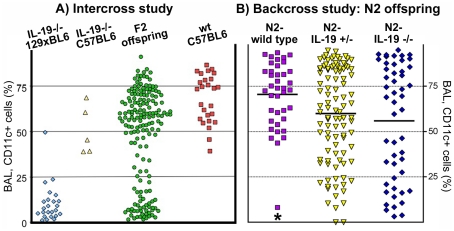
Strain-dependent decreased abundance of CD11c+ cells in the BAL of naive IL-19-/- 129xBL6 mice.The abundance of CD11c+ cells in the BAL (%) from individual mice is shown for the following parental and offspring strains: (A) IL-19-/- 129xBL6 (blue diamonds); IL-19-/- C57BL/6 (yellow upright triangles); second generation, intercross F2 offspring from a cross between IL-19-/- 129xBL6 and IL-19-/- C57BL/6 parental lines (green circles); and for comparison, wild-type C57BL/6 (red squares). (B) Backcross N2 offspring originating from a cross between IL-19-/- 129xBL6 and wild-type C57BL/6 mice. The mice were genotyped and found to be wild type (il19
+/il19
+ purple squares), heterozygous (il19
+/il19
- yellow downward triangles) or IL-19-/- (il19
-/il19
- blue diamonds). Data from individual mice are shown. Horizontal lines indicate means. Data were pooled from 4-6 experiments. Statistical analysis was with ANOVA followed by Dunnett multiple comparison test, * p<0.05 for comparison between N2-wild type and N2-IL-19 -/-.